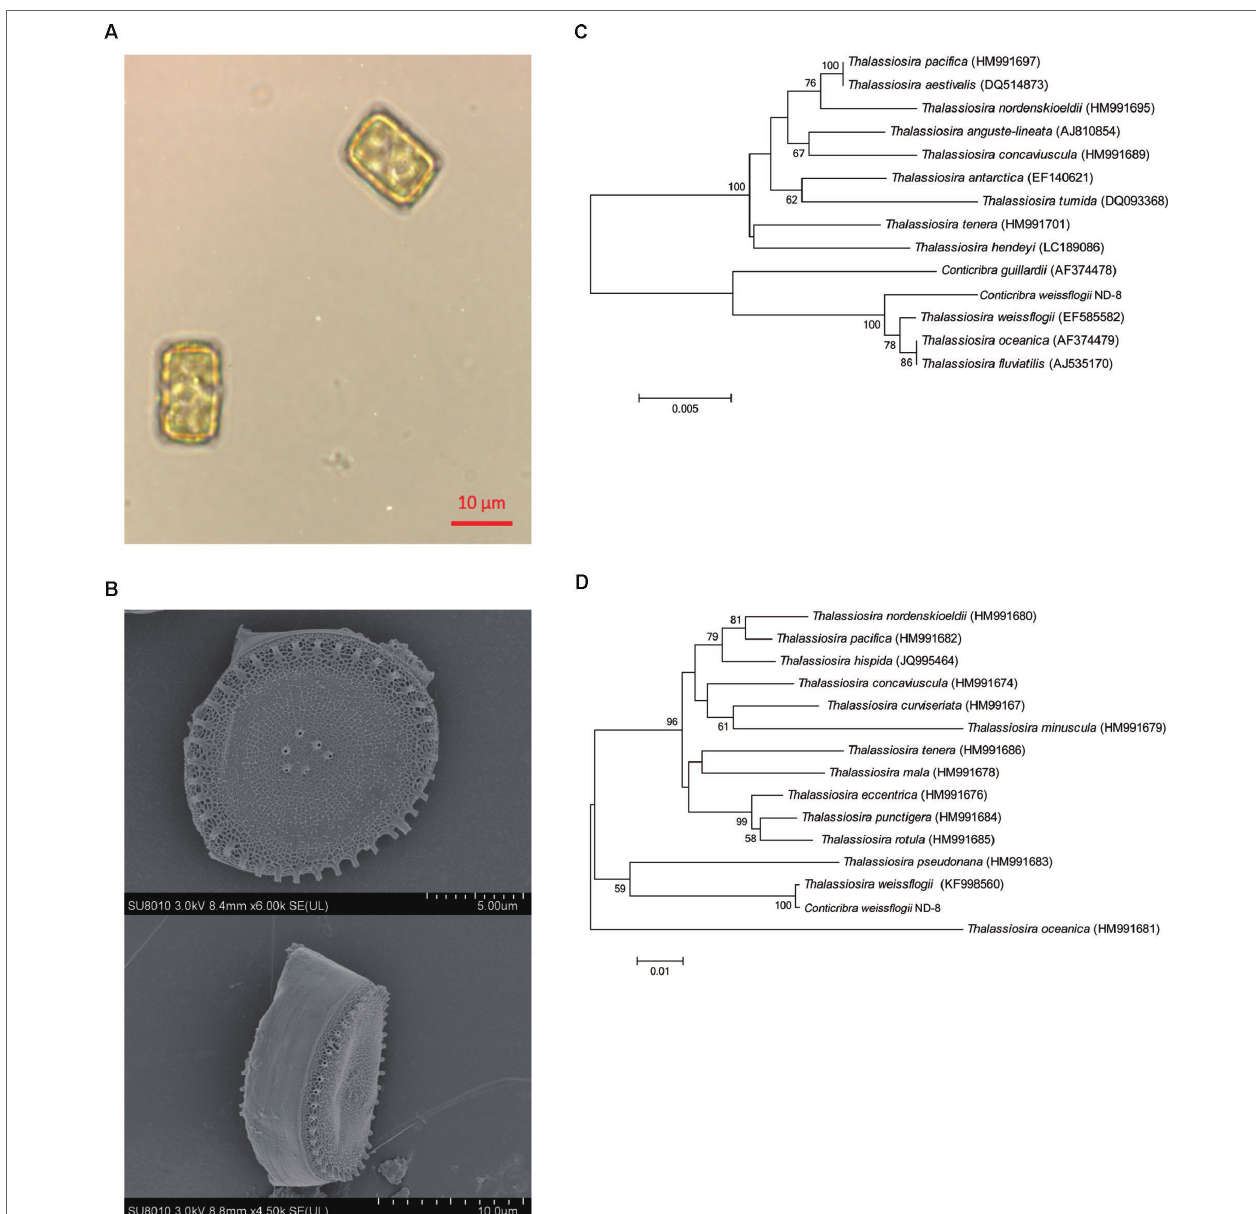
FIGURE 1 | Morphological and molecular identification of Conticribra weissflogii ND-8. (A) Morphology of C. weissflogii ND-8 and (B) intact cells observed using a scanning electron microscope. Scale bars: (A) 10 μm; (B) 2 μm. (C) The neighbor-joining tree of the 18S rDNA sequences of C. weissflogii ND-8 and (D) the neighbor-joining tree of the internal transcribed spacer (ITS) rDNA sequences of C. weissflogii ND-8. The numbers at the nodes are the bootstrap scores (above 90%) obtained from 1,000